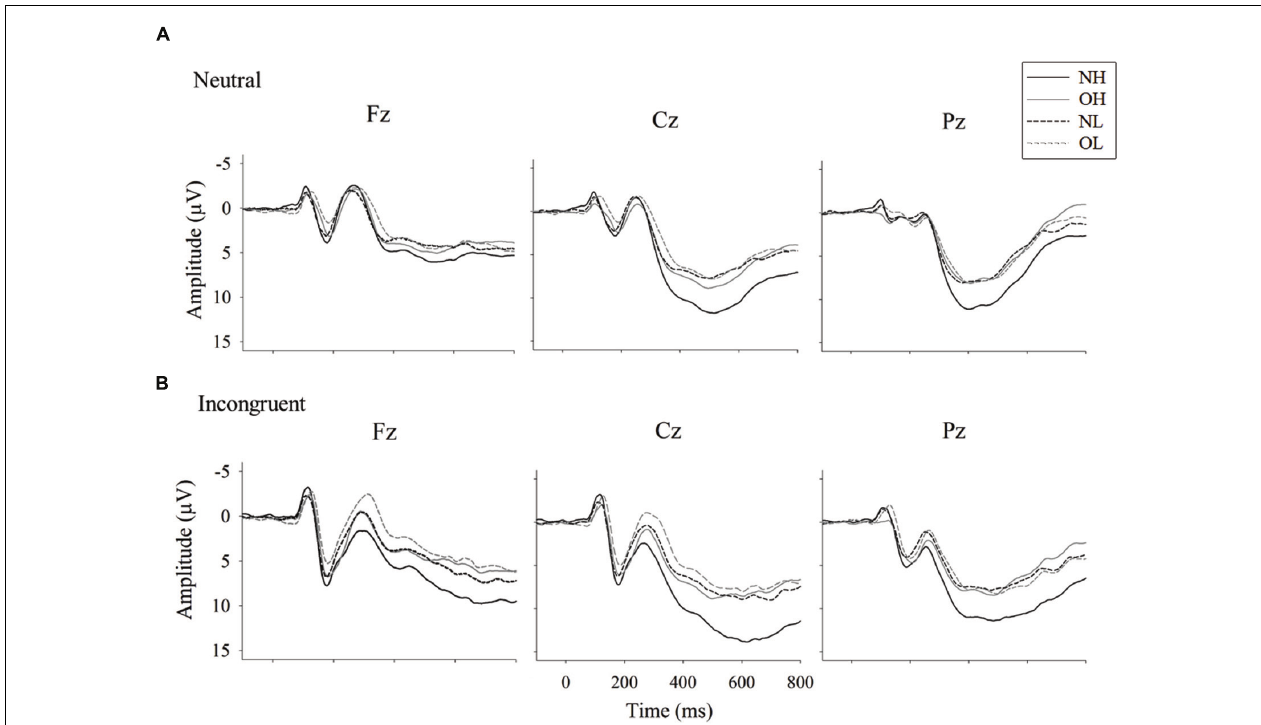
FIGURE 2 | Grand-averaged ERP waveform for Stroop neutral (A) and incongruent (B) conditions (B) across four groups: normal-weight and high-fit (NH), obese-weight and high-fit (OH), normal-weight and low-fit (NL), and obese-weight and low-fit